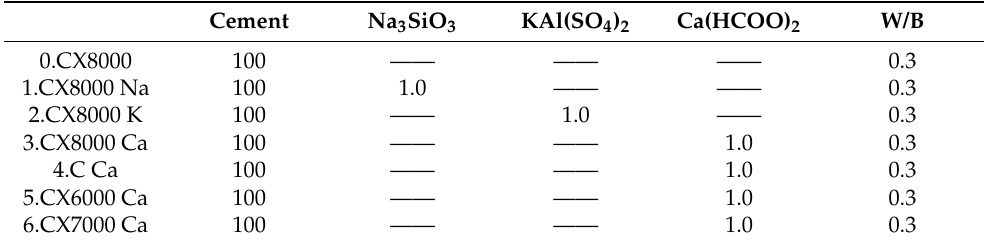
Table 3. Ultrafine cement with different accelerators and particle sizes system mortar mix proportion.